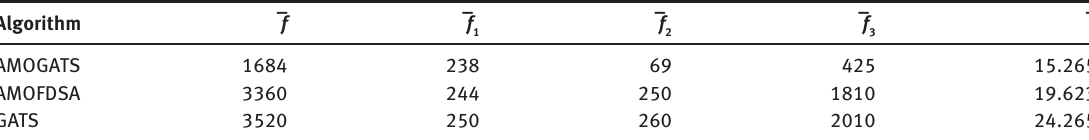
Table 4: Performance Comparison of